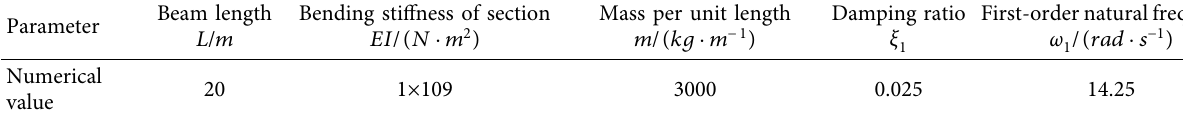
Table 1: Simply supported beam